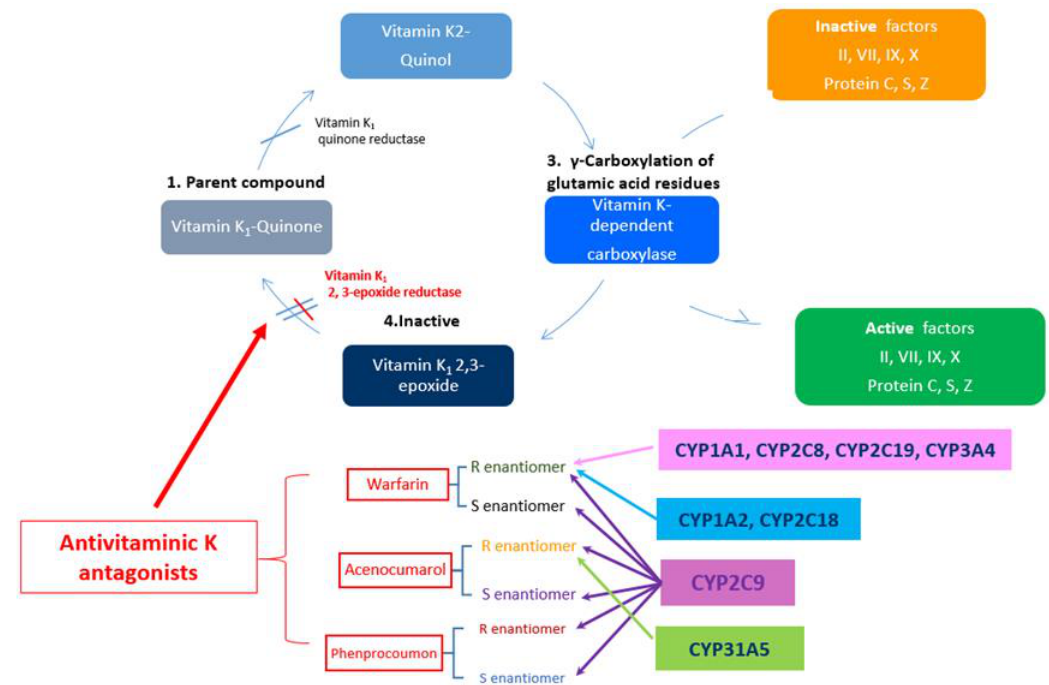
Figure 1. Mechanism of action of VKA. CYP1A1 Cytochrome P450 family 1, subfamily A, polypeptide1; CYP1A2 Cytochrome P450 family 1, subfamily A, polypeptide 2; CYP2C18 Cytochrome P450 family 2, subfamily C, polypeptide 18; CYP2C19 Cytochrome P450 family 2, subfamily C, polypeptide19; CYP3A4 Cytochrome P450 family 3, subfamily A, polypeptide 4; CYP2C9 Cytochrome P450 family 2, subfamily C, polypeptide 9; CYP2C3A5 Cytochrome P450 family